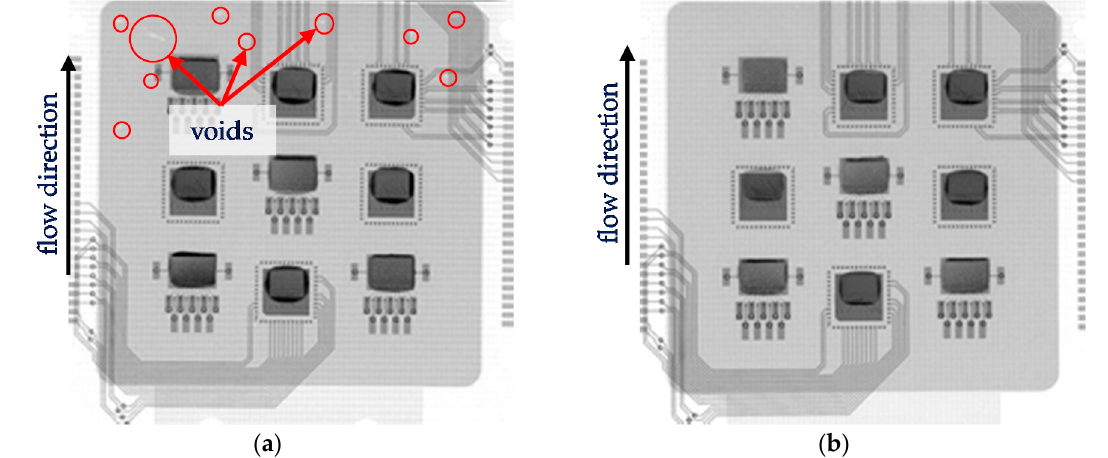
Figure 4. X-ray image from a PCB panel encapsulated using ( a ) 10 bar and ( b ) 30 bar cure pressure. Red circles marks voids.